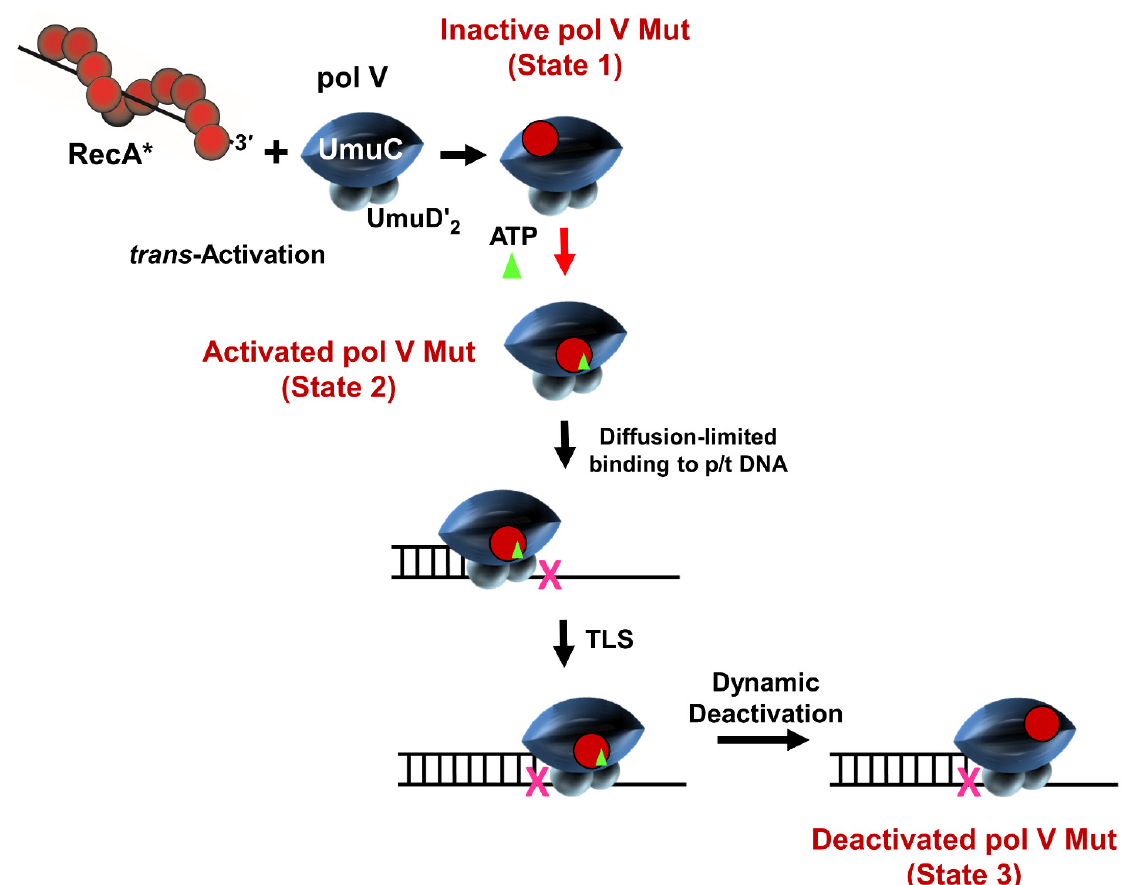
Figure 2. Regulation of pol V Mut. The first step in regulation of pol V Mut is the transfer of a single RecA monomer from a 3’ end of a RecA nucleoprotein filament (RecA *) to form pol V Mut (UmuD’ 2 C-RecA). This protein complex is in an inactive state (State 1) and cannot bind to p/t DNA. A subsequent addition of ATP/ATP γ S activates pol V Mut (active state = UmuD’ 2 C-RecA- ATP; State 2). Due to ATP induced reorientation of RecA relative to UmuC and UmuD’ molecules, state 2 can bind to p/t DNA and synthesize DNA, including TLS (X denotes a DNA template lesion). After performing one cycle of DNA synthesis, the pol V Mut deactivates dynamically (State 3) and cannot perform any more rounds of DNA synthesis.